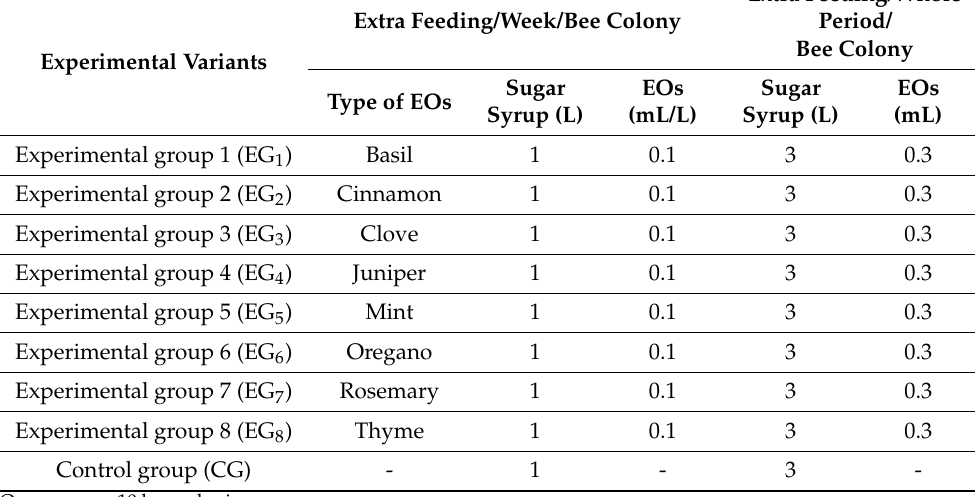
Table 1. Experiment organization